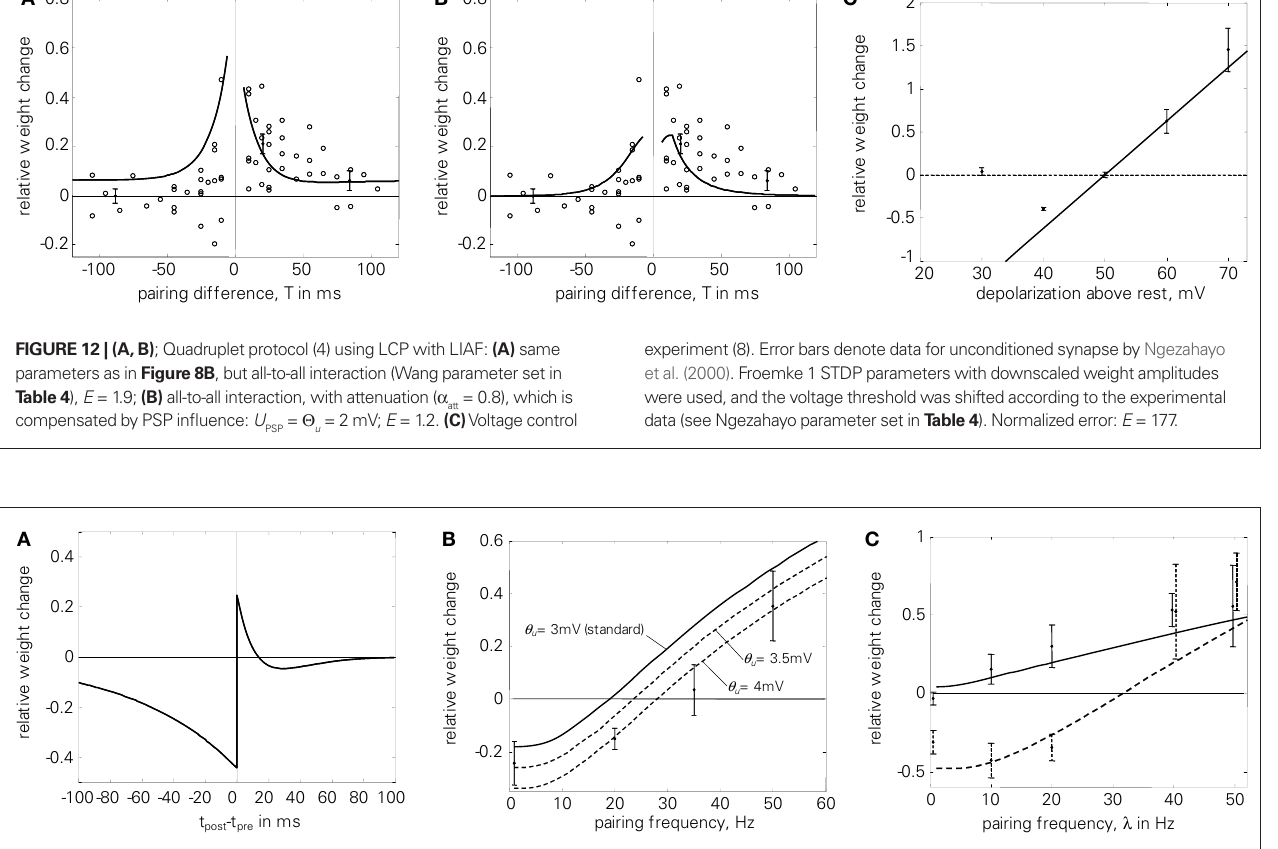
FigurE 13 | Experiments of Sjöström et al. (2001) using LCP with LiAF and Sjöström parameter set (cf. Table 4 ). (A) resulting STDP window; (B) correlated rate protocol (7), E = 6.3; (C) Frequency-dependent STDP (2), E = 1.6. Total error: E =